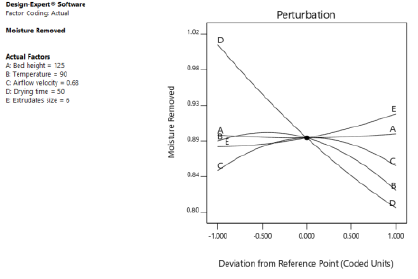
Figure 2: A perturbation plan for moisture ratio